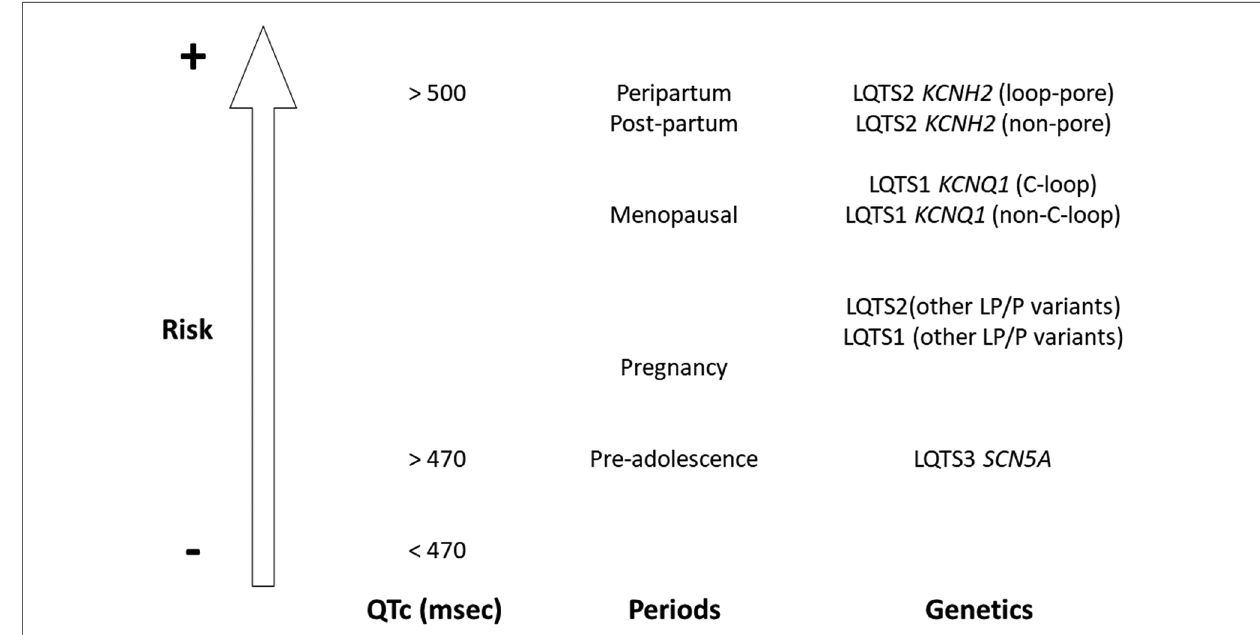
FIGURE 2 Risk of malignant arrhythmias in women after the onset of adolescence. High risk situations are QTc more than 500msec, peripartum and post-partum periods, and deleterious variants in loop-pore of the KCNH2 gene. QTc: QT corrected; LQTS: Long QT Syndrome; LP/P: Likely